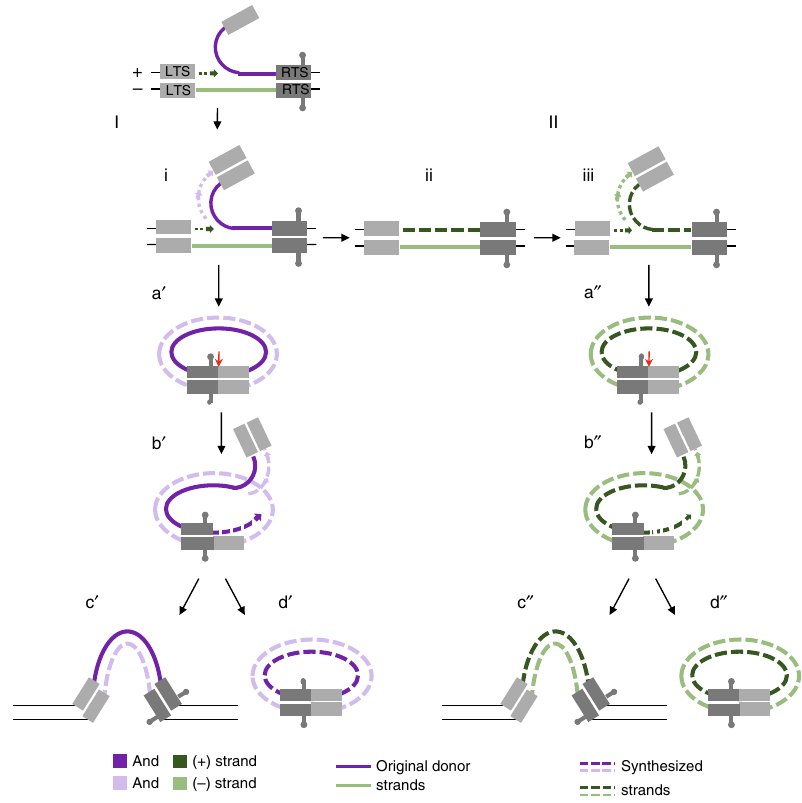
Fig. 6 Proposed pathways of transposon circle formation together with replication and integration during Helraiser transposition. Transposon circle formation using the original donor site is shown on the left (I). Following the nicking of transposon plus strand at the LTS, a replication fork is established at the nick site (i). Leading strand synthesis reconstitutes the transposon donor site (ii), while lagging strand synthesis takes place on the displaced transposon strand. This results in a formation of dsDNA transposon circle (a ′ ) after the second cleavage reaction takes place at the RTS of the displaced transposon strand. Generated dsDNA transposon circle potentially serves as a transposon donor (b ′ ). Following the transposon plus-strand cleavage at the LTS-to-RTS junction site on a dsDNA transposon circle, a replication fork is established at the nick site (b ′ ). Leading strand synthesis regenerates the transposon donor site on the transposon circle, while the lagging strand synthesis results in a dsDNA transposon copy that can be integrated in the host genome (c ′ ) or form a new dsDNA transposon circle (d ′ ). After resynthesis of the original transposon donor site (shown on the right (II)), transposon circle formation and replication include the same steps illustrated for the pathway (I). Solid line: original transposon donor strand; dashed line: synthesized transposon strand. Transposon plus strand is shown in dark purple or in dark green; transposon minus strand is shown in light purple or in light green. Red arrow marks the position of the transposon plus-strand cleavage at the LTS-to-RTS junction